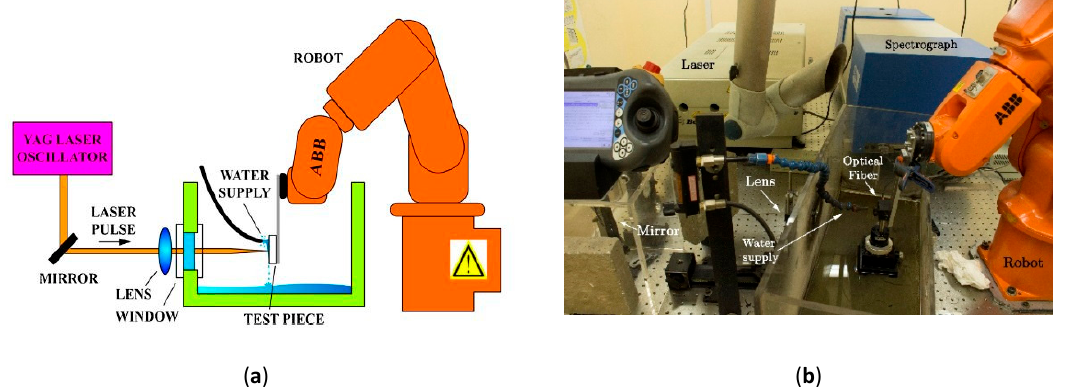
Figure 1. Experimental setup used in the reported Laser Shock Processing (LSP) experiments: ( a ) Scheme; ( b ) Photo.